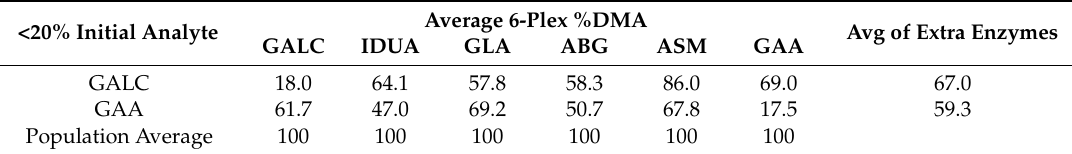
Table 1. Pilot cohort showing the averaged percent of mean activity values for each enzyme; for those specimens with either GALC or GAA that is below 20% of the daily